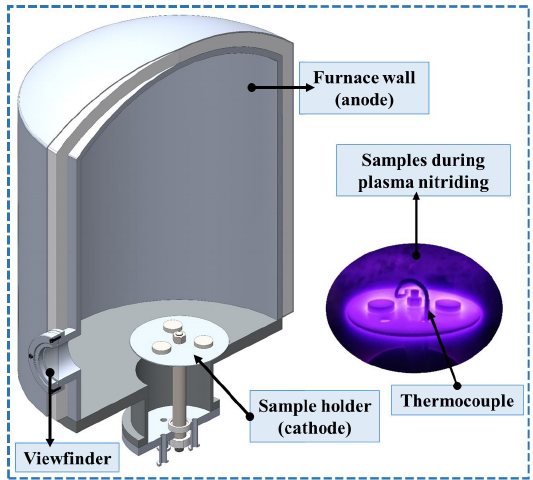
Figure 1. Simple scheme of the system showing how the samples and thermocouple were positioned. Table 1. Chemical composition and mechanical properties of the DIN 18MnCrSiMo6-4 steel. Chemical elements (wt.-%)